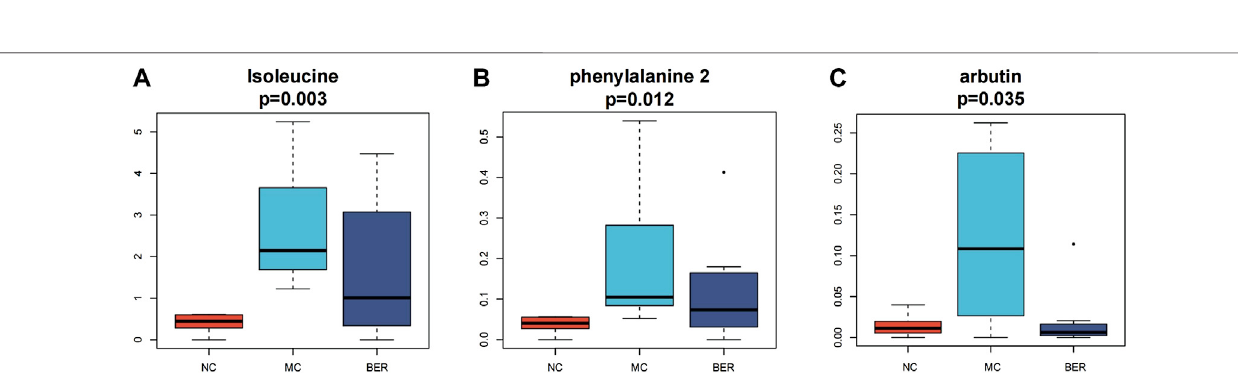
Frontiers in Pharmacology |